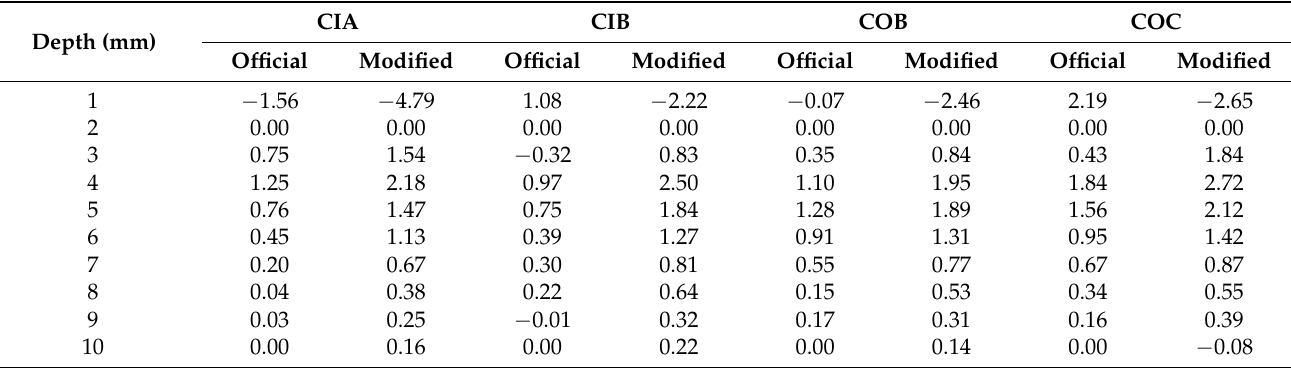
Table 5. Relative dose difference, expressed in percentage, in the central axis between the reference data provided by BEBIG and our calculations using the official and modified geometric models. Positive/negative values indicate that the MC value is higher/lower than the reference value. The normalization was set to the CAX point at 2 mm